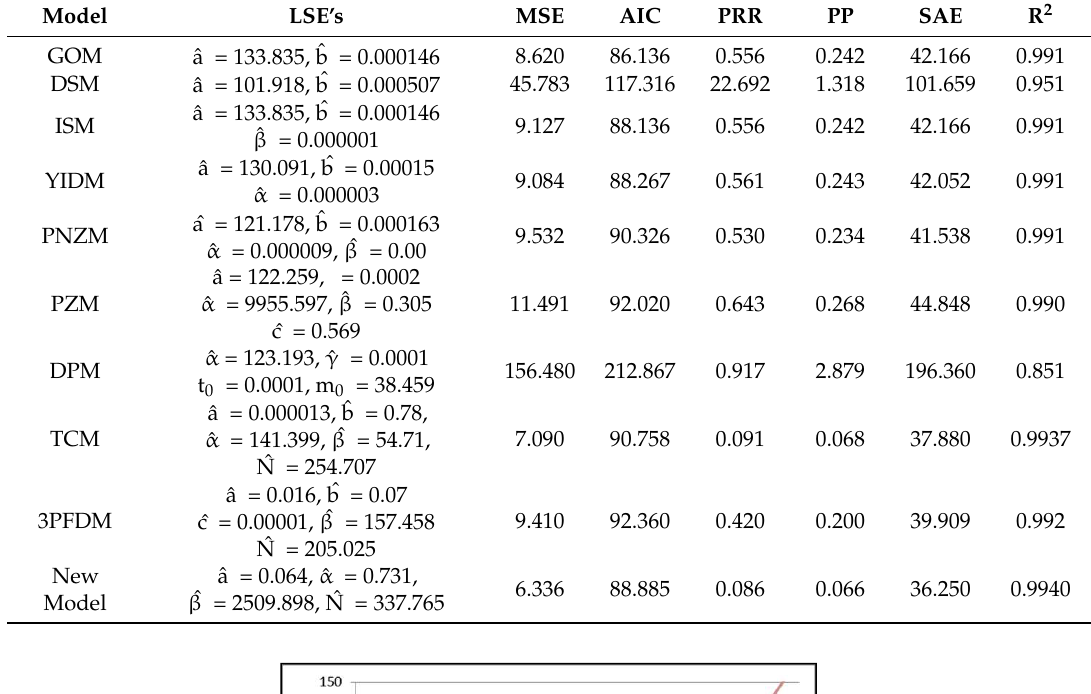
Table 7. Model parameter estimation and comparison criteria from MRS data set (DS3).